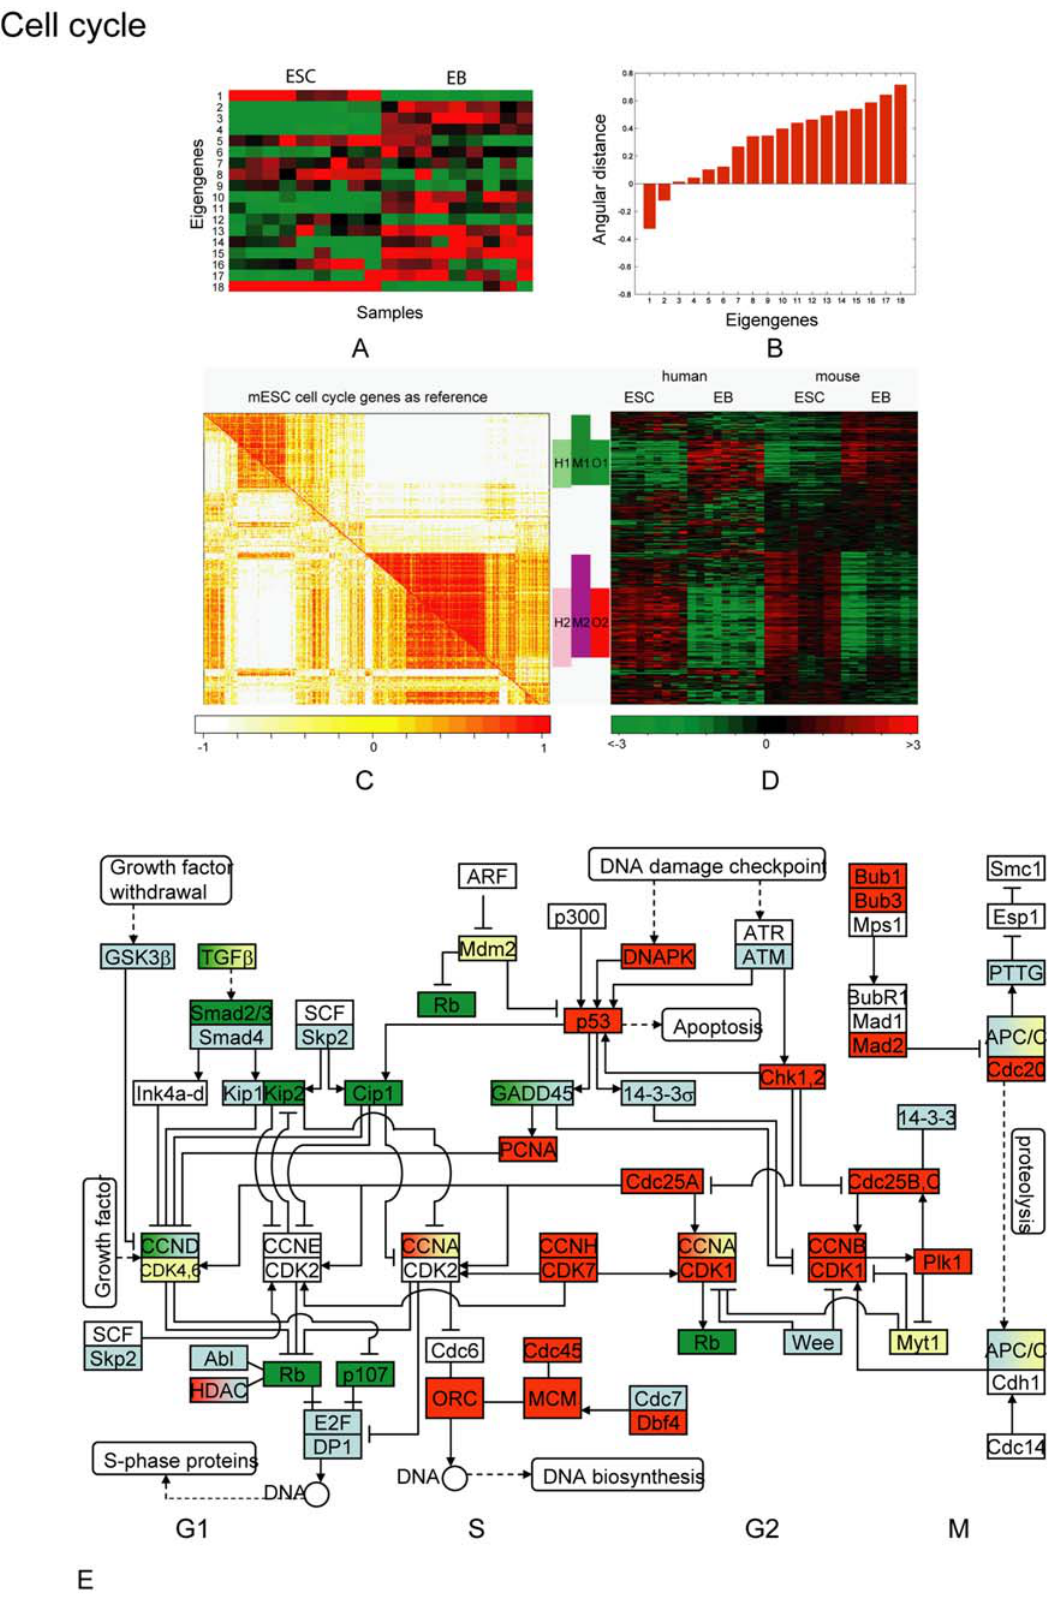
Figure 1. The identification of conserved and divergent co-expression gene clusters in the cell cycle from human and mouse ESC- EB data. The analysis results for AKT/PTEN, JAK/STAT, TGF b , WNT and other pathways are presented in supplementary Figures S1 through S4. A) Heatmap display of the tailing matrix shared between human and mouse data by GSVD. The expression of each eigengene (rows) across all ESC and PLoS ONE |